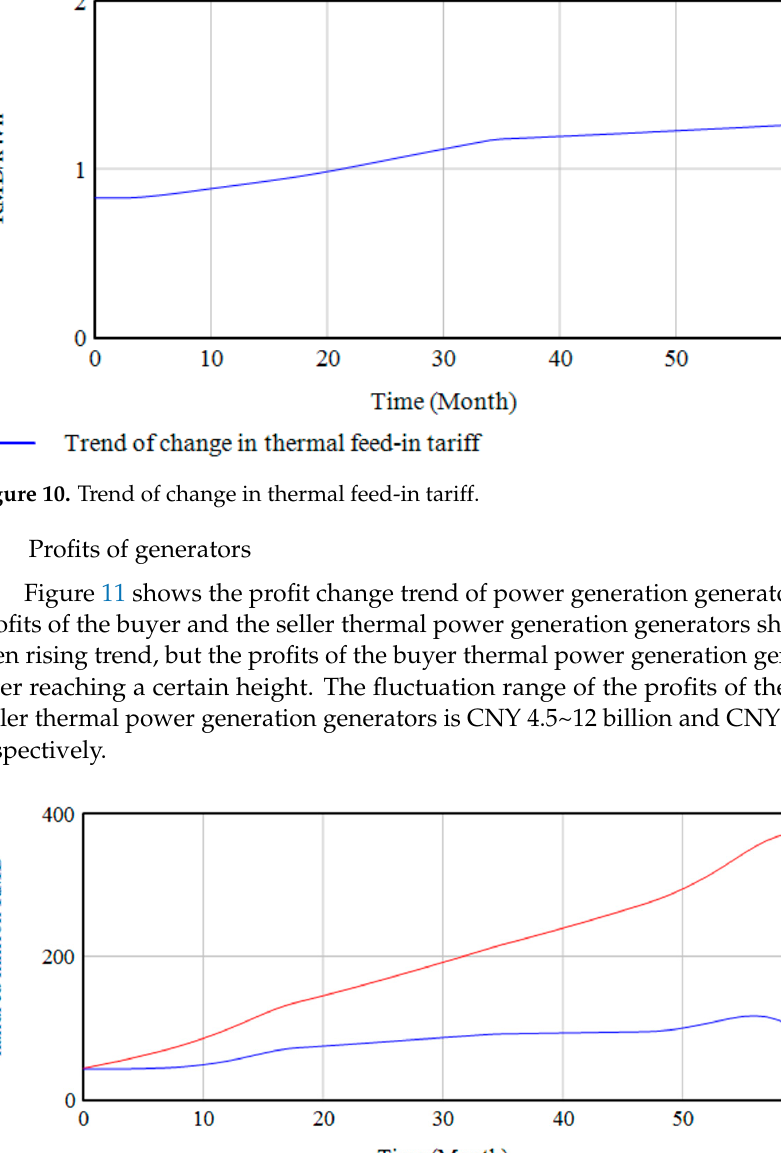
Figure 12. Trend of change in grid corporate profits. During the operation of the carbon trading market and power trading market, the profits of power grid enterprises will fluctuate due to the transmission of carbon costs to power prices. In the initial stage of carbon market, due to the imperfect carbon cost trans- mission mechanism, the profits of grid corporate are less affected by it. However, as the carbon market becomes full-fledged, the carbon price is transmitted to the power price, resulting in an increase in the cost of power purchasing of the power grid enterprises. In addition, the profits are further reduced due to the COVID-19 epidemic and the periodic price reduction policy. As the coal price rises, the power price also rises and the power consumption only increases, so the profits of power grid enterprises are rising again. Alt- hough grid corporate do not directly participate in the carbon trading market, their pro- duction and operation will still be indirectly affected by the carbon market. 5.3. Analysis of Multi-Scenario Results According to the development of the EU carbon market and the current state of China’s carbon market, the development of the national carbon market can be divided into three stages: the initial stage, the middle stage and the late stage of carbon market.